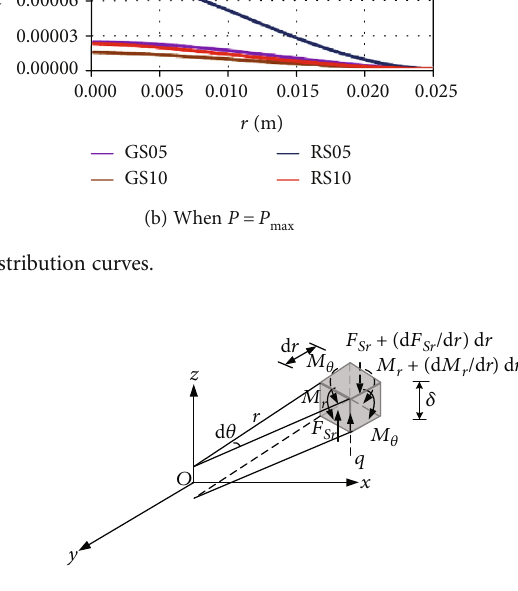
Figure 9: Internal force distribution of microelement in the thin disc rock